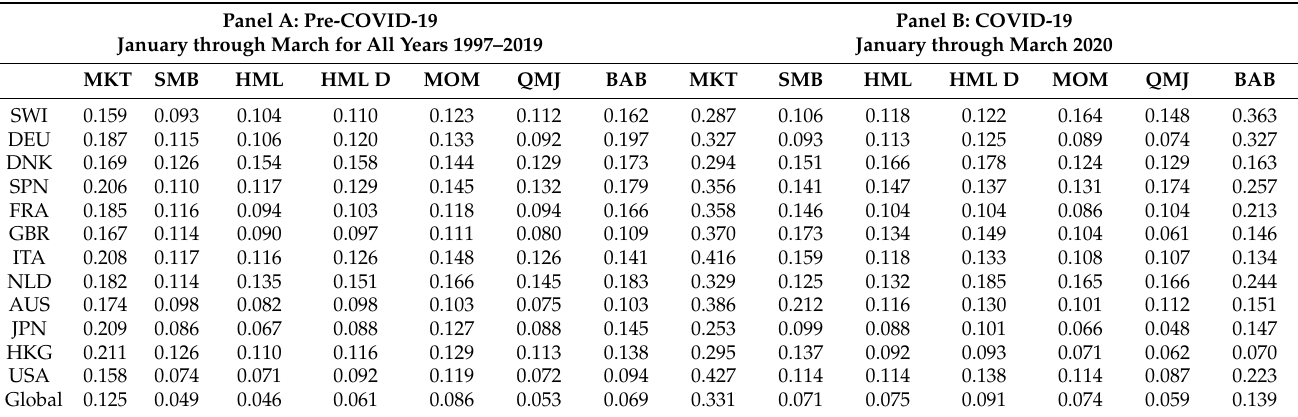
Table 2. Annualized Volatilities. Panel A: Pre-COVID-19